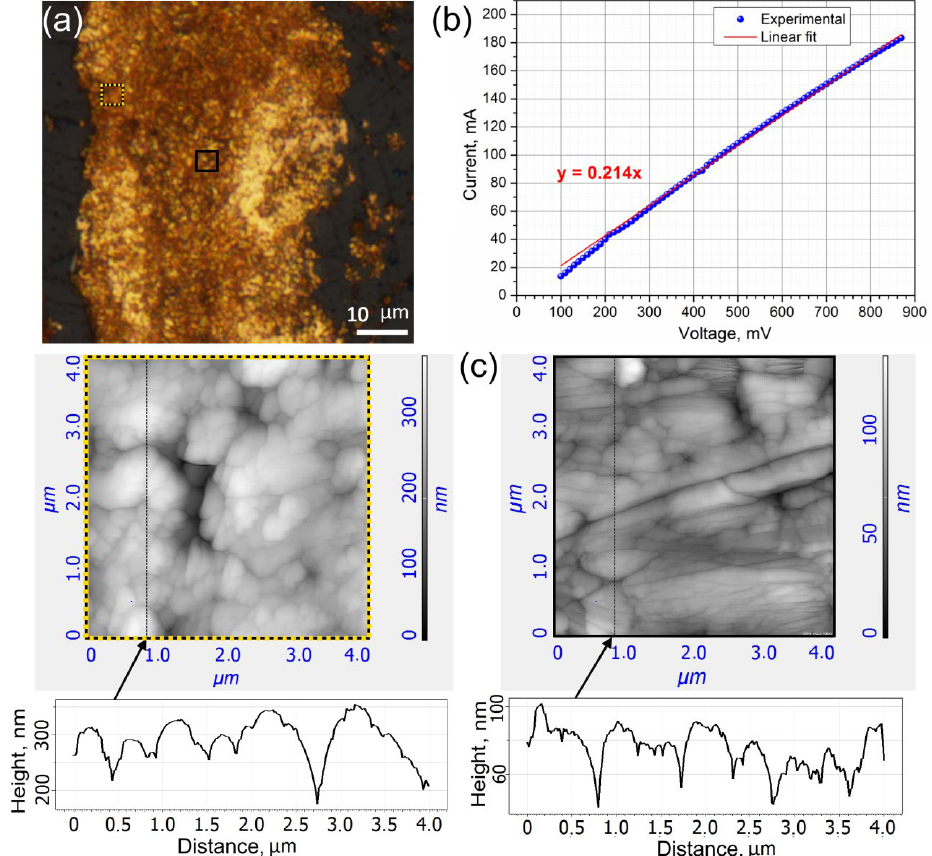
Figure 3. ( a ) Brightfield optical image of gold trace deposited at 500 kHz, 500 nJ, 1 mm/s by three laser beam passes corresponding to 4500 pulses per irradiated spot; ( b ). Current–voltage curve for the laser-deposited gold micropatterns; ( c ) AFM images and corresponding profiles registered for the gold track. Regions of interest are indicated by yellow dotted and black solid squares in ( a